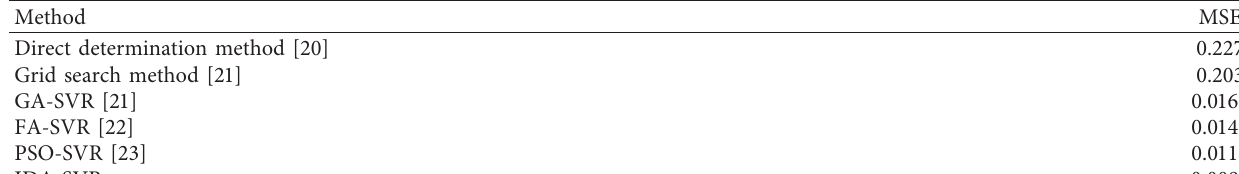
Table 7: Comparison of performance between IDA-SVR and other